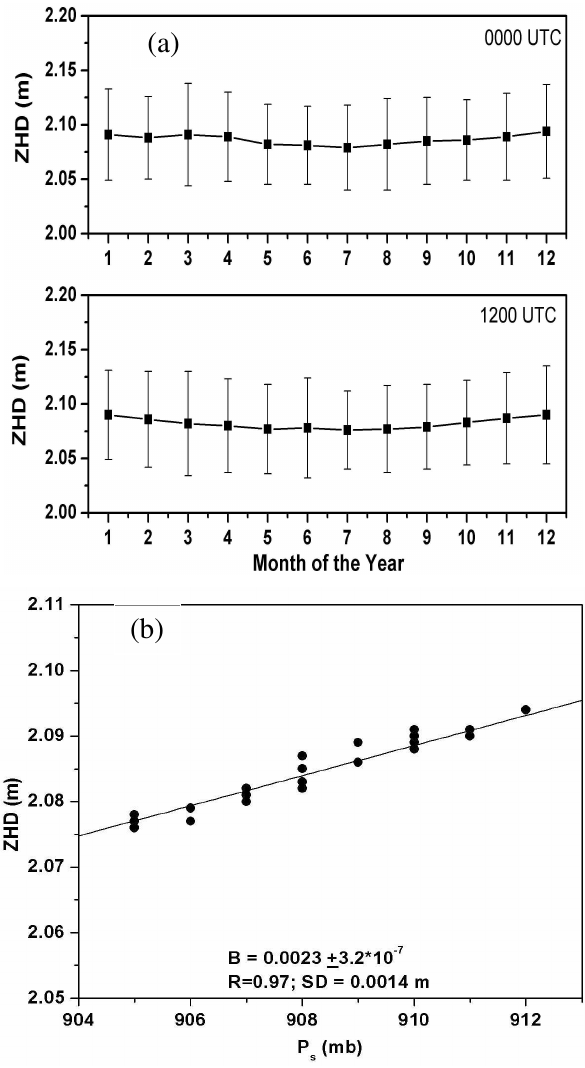
Fig. 2. Monthly mean values of dry range error in the zenith direc- tion (ZHD) for Bangalore at 00:00 UTC and 12:00 UTC, respec- tively in the upper panel and lower panel estimated by using mean profiles of atmospheric pressure ( P) and temperature ( T ) for the period 1995–1997, obtained from the radiosonde data (vertical bars in both the panels are standard deviations in each month due to the day-to-day variations of P and T , estimated by applying the error propagation formula (Ku, 1966)) (a) , and dependence of ZHD on surface pressure ( P S ) is derived using the monthly mean values of ZHD and P S (b)